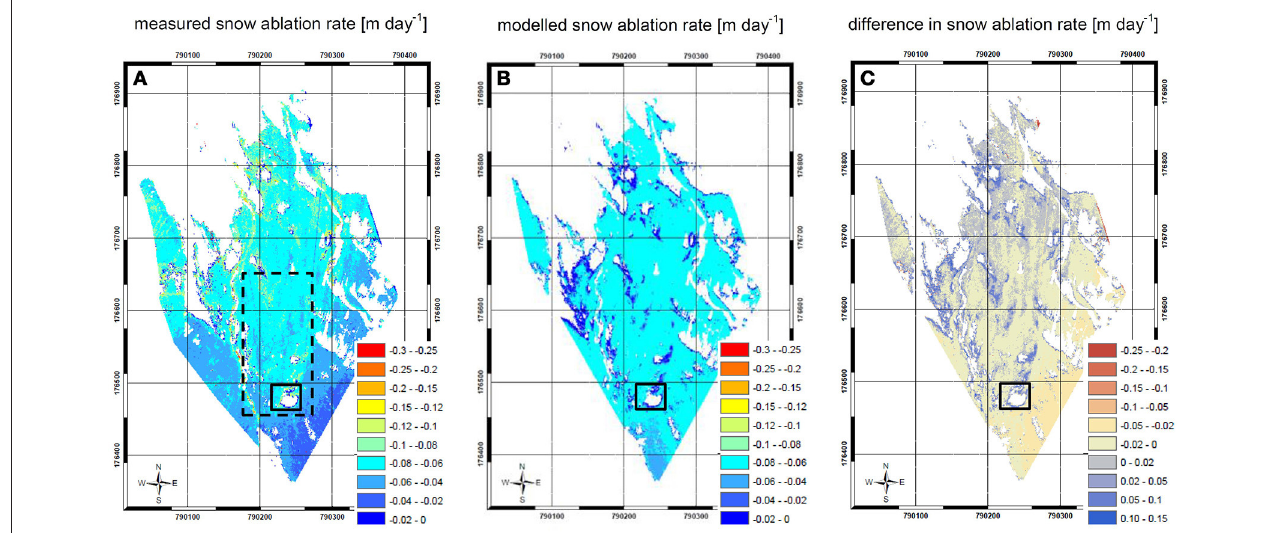
FIGURE 4 | Snow ablation rates [m day − 1 ] for the 06 May 2014 at the Gletschboden area in the upper Dischma valley. (A) Terrestrial laser scanning measurements, (B) Alpine3D model results, (C) model-measurement. The dashed box in (A) shows the location of the investigated area of Figure 5 .